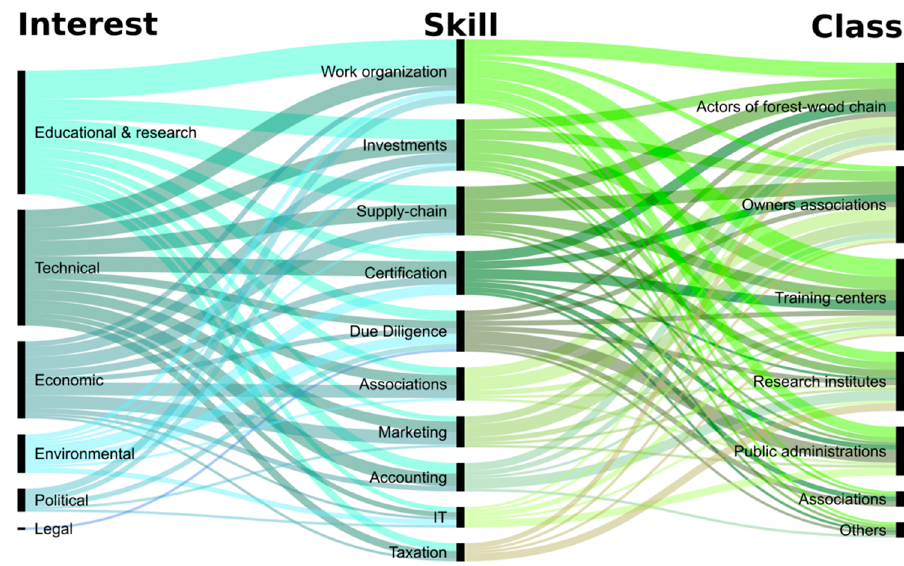
Figure 4. Stakeholder preferences regarding entrepreneurial training, divided by interest and class.